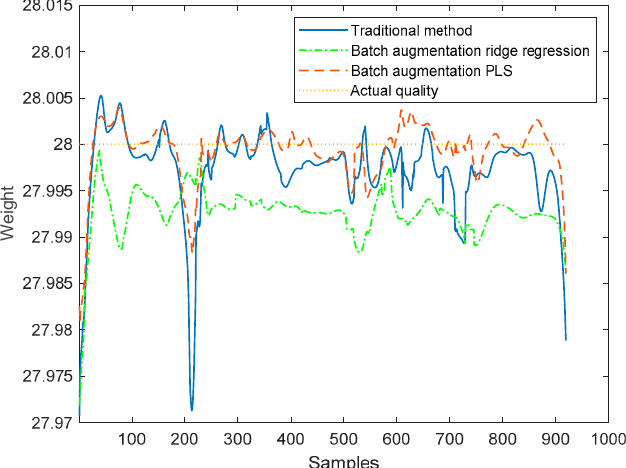
Figure 8. Quality prediction of batch 50.